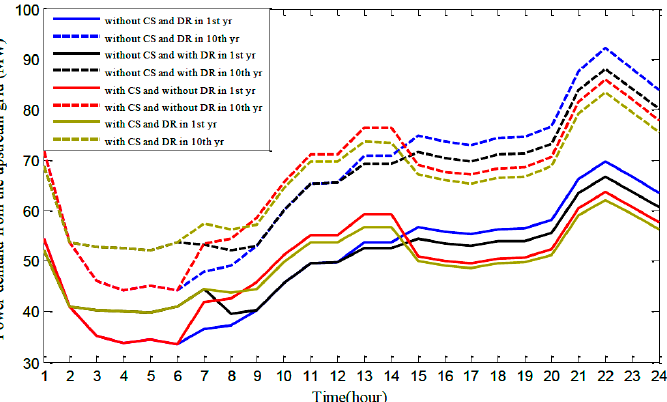
Figure 12. Load curve of the studied network in different scenarios and application of 10-year load growth.